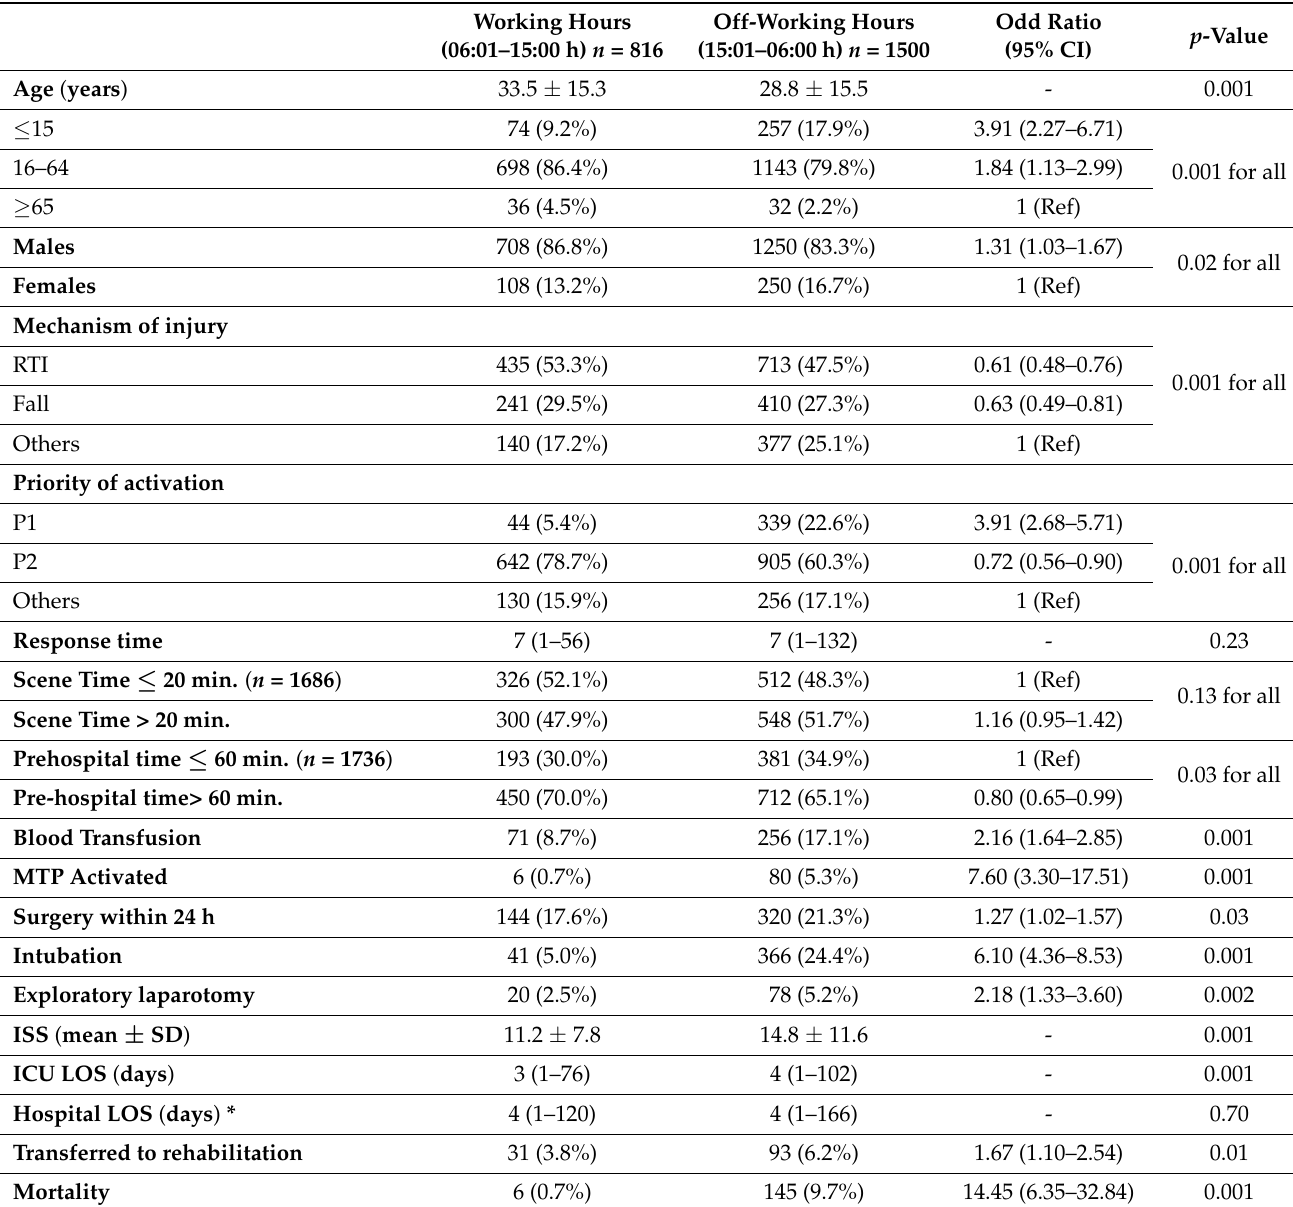
Table 1. Comparison of demographics and outcome by time in a